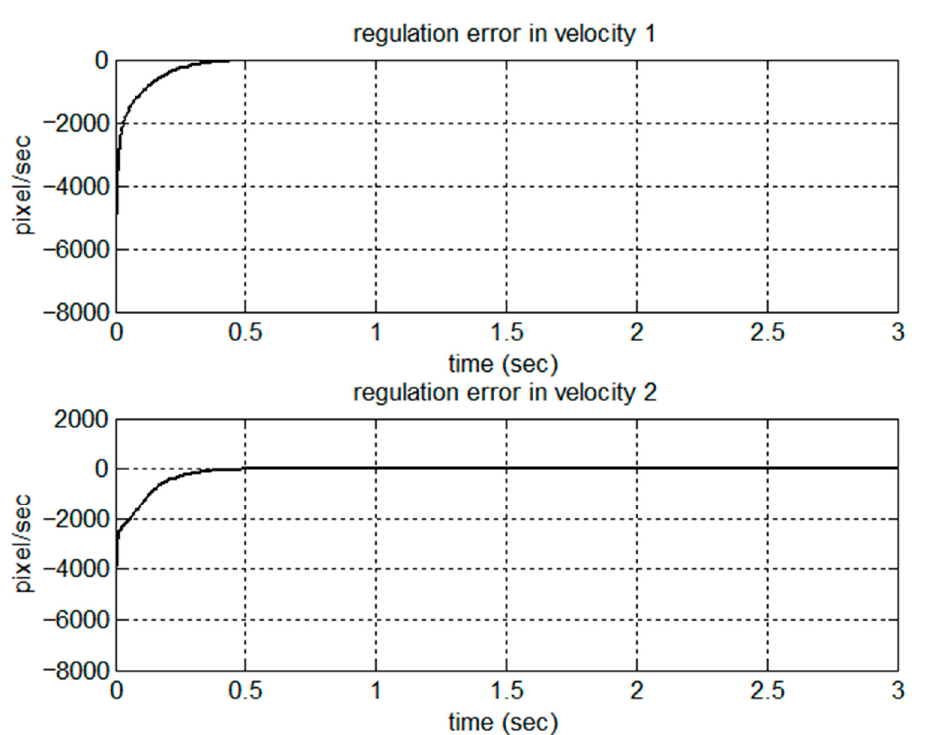
Appl. Sci. 2020 , 10 , x FOR PEER REVIEW Figure 11. Regulation error in positions. Figure 11. Regulation error in positions.